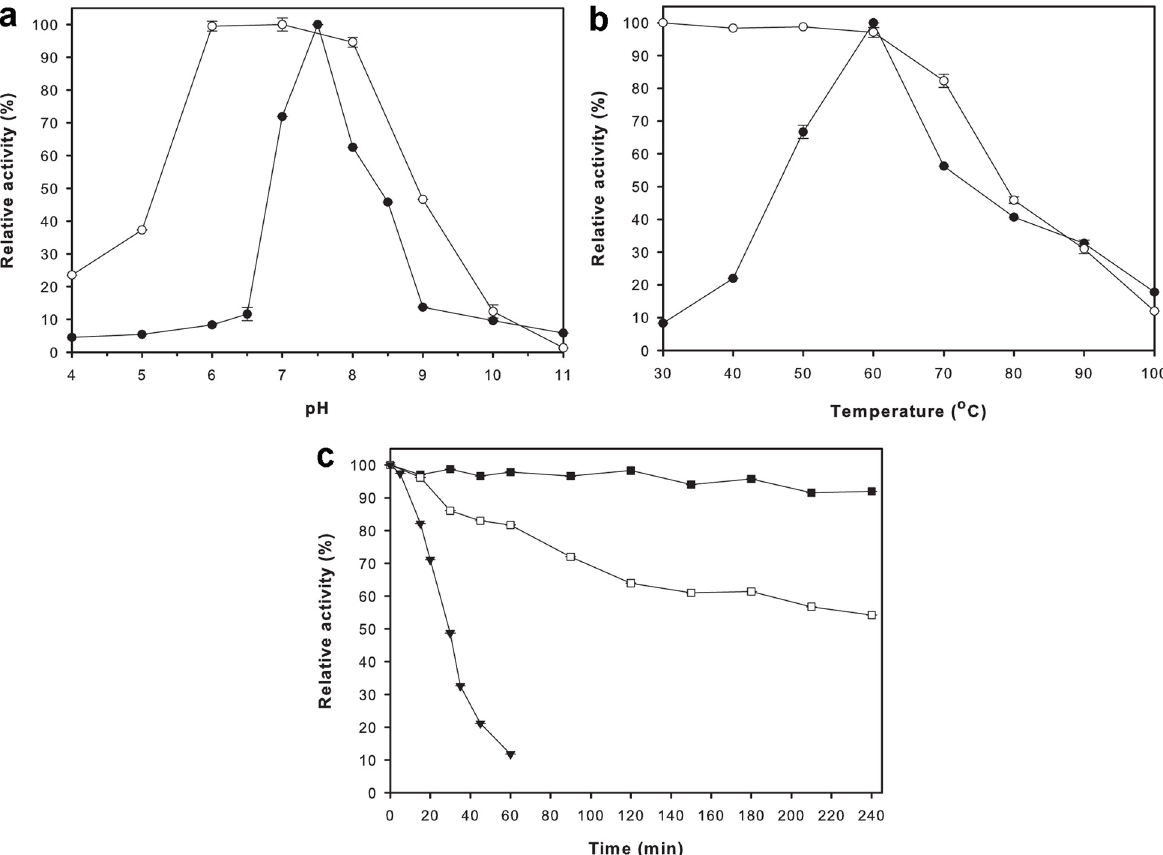
Figure 2. Biochemical characterizations of ApuASK. ( a ) Effects of pH on activity ( ● ) and stability ( ○ ) of ApuASK; ( b ) Effects of temperature on activity ( ● ) and stability ( ○ ) of ApuASK; ( c ) Thermostability of ApuASK at 60 °C ( ■ ), 65 °C ( □ ), and 70 °C ( ▼ ). Values are the mean ± standard error of triplicate